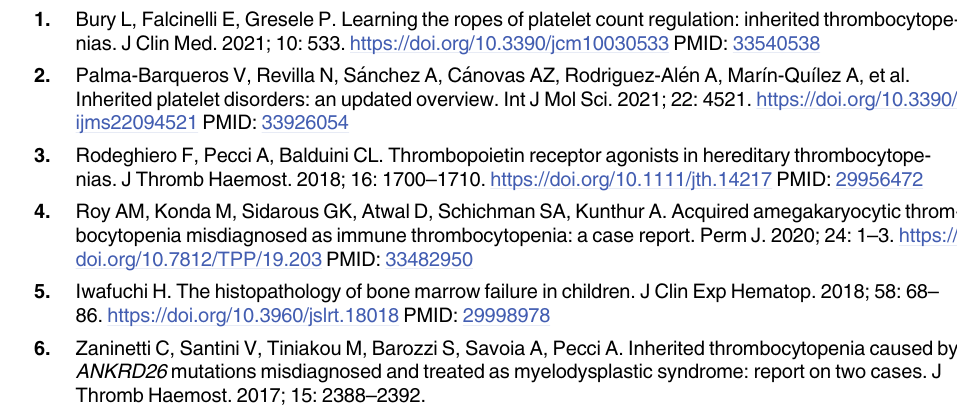
S1 Table. Gene list for 647 gene